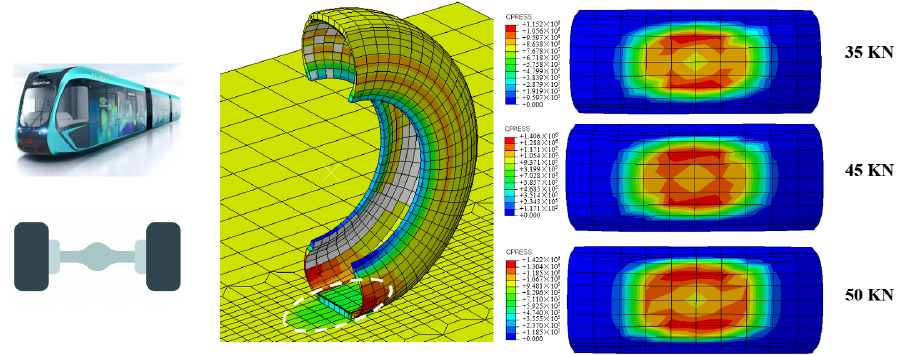
Figure 13. Tire–pavement contact press under different axle load.